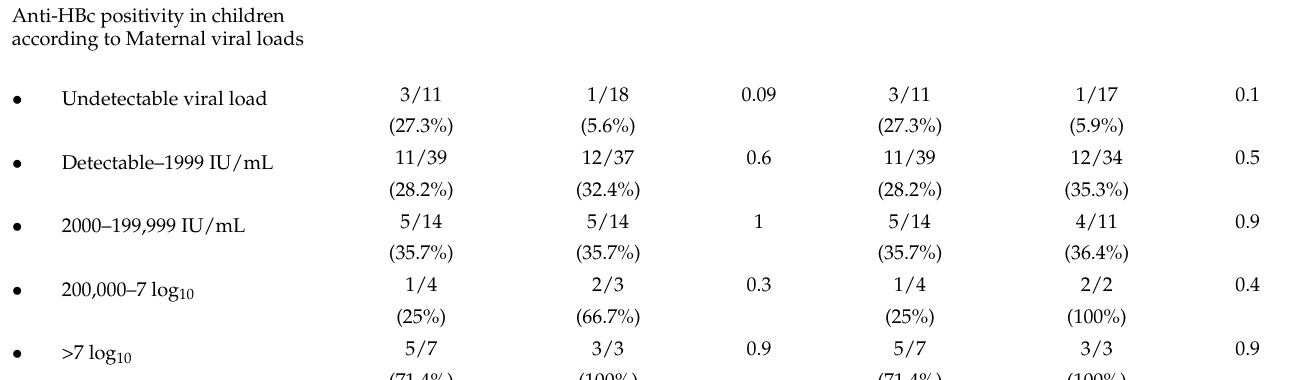
MTCT cases. Three mothers of the 6 HBsAg+ infants had at delivery > 7 log 10